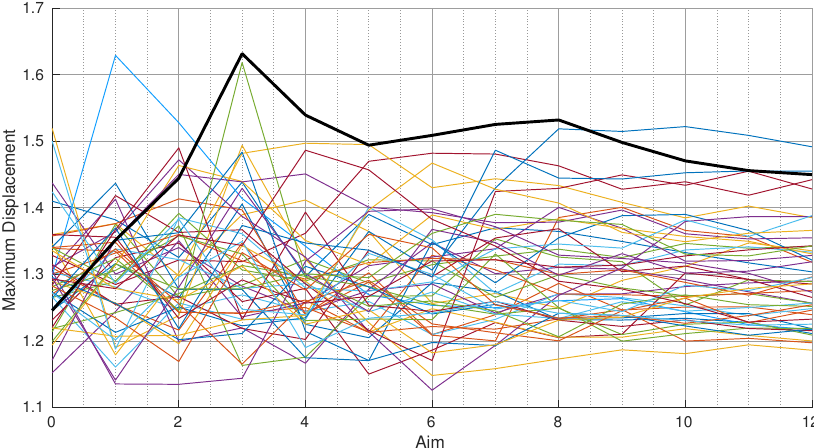
Figure 15. Maximum vibration amplitude for increasing intentional mistuning amplitude for 50 random mistuning patterns. Rotor B, [ 1,0, − 1, . . . ,1,0, − 1 ] pattern, ξ = 10 − 3 .